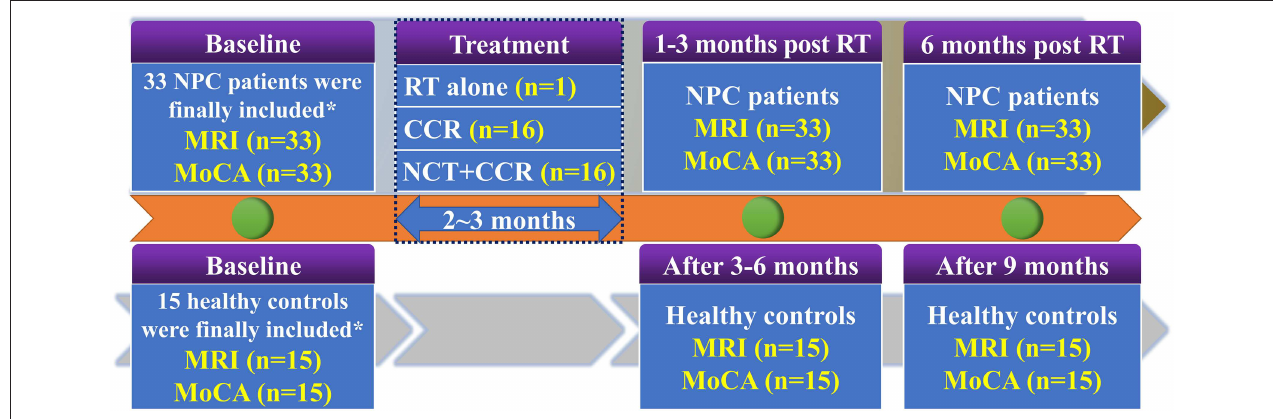
FIGURE 1 | Enrolment and follow-up procedures for patients with NPC and healthy controls. CCR, Concurrent Chemotherapy and Radiotherapy; MoCA, Montreal Cognitive Assessment; NCT, Neoadjuvant Chemotherapy; NPC, nasopharyngeal carcinoma; RT, radiation therapy. *38 newly diagnosed patients with NPC and 20 comparable healthy controls were initially included. Ten subjects (5 NPC patients and 5 healthy controls) were discarded due to excessive head motion. Finally, 33 patients with NPC and 15 comparable healthy controls were included.